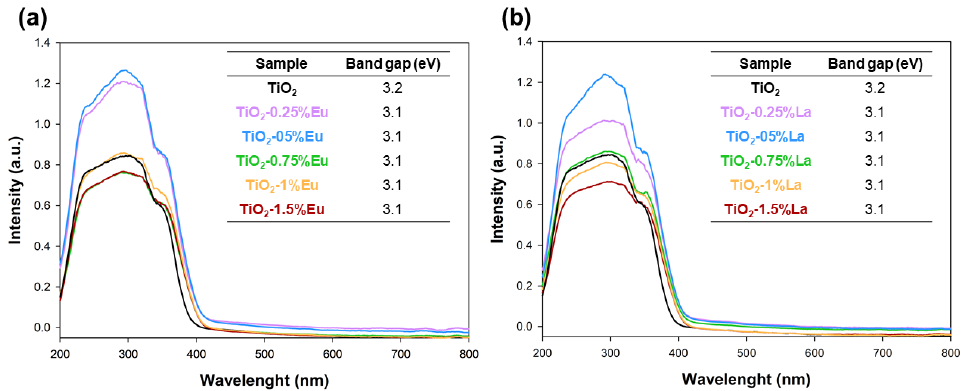
Figure 9. The absorption spectra of TiO 2 -Eu ( a ) and TiO 2 -La ( b ) samples.